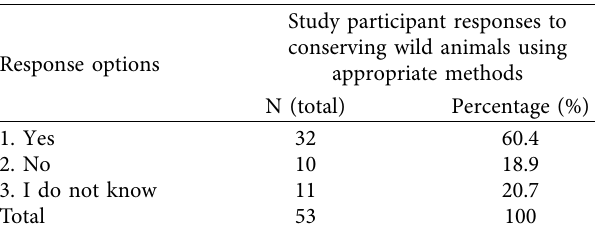
Figure 8: Response of killing of all wild animals to solve the conflict problem. Table 12: Study response to conserving wild animals using ap- propriate